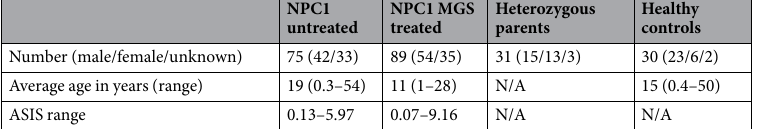
Table 1. Clinical characteristics of NPC1 patients and healthy control subjects included in this